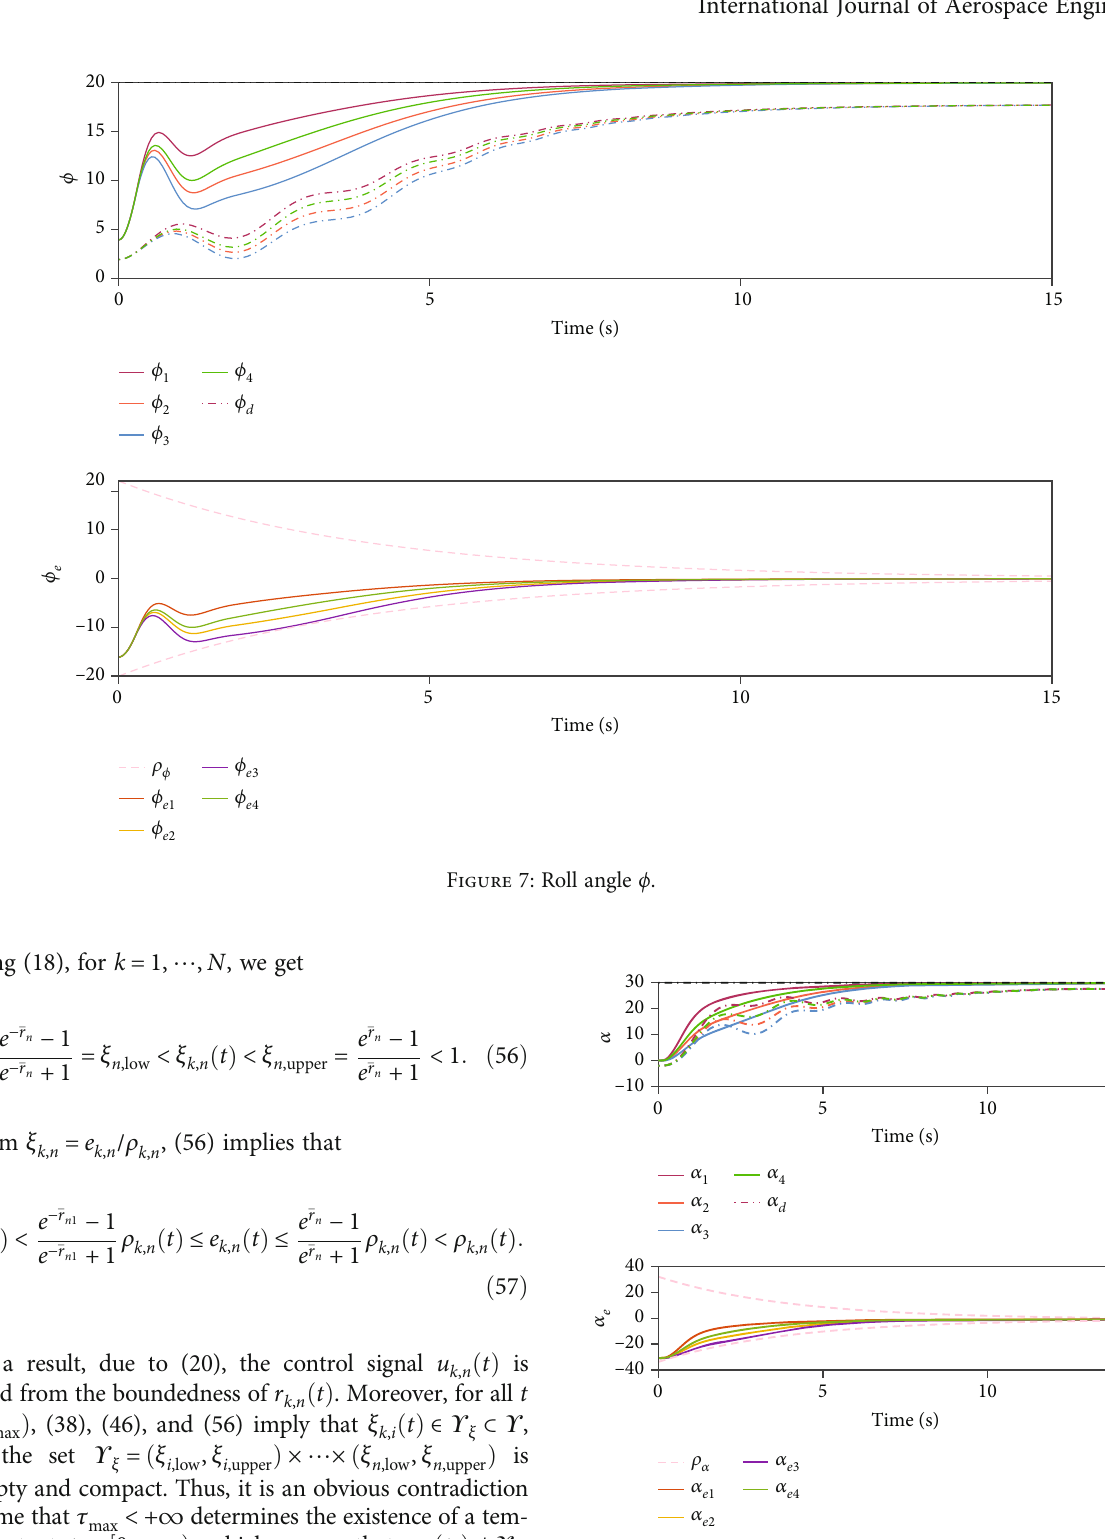
Figure 8: Attack angle α